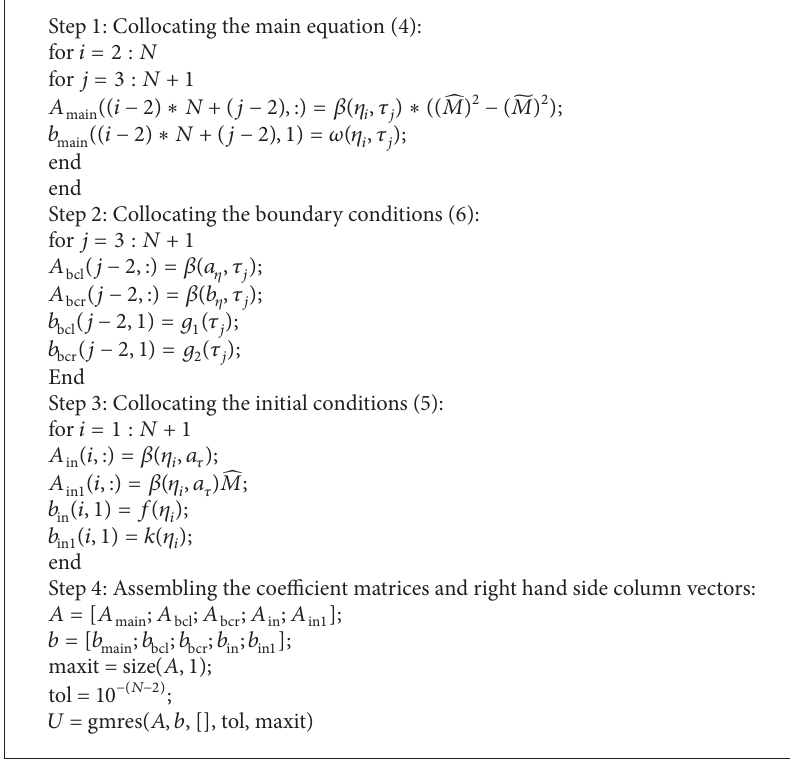
Algorithm 2: Implementation of BCM for solving